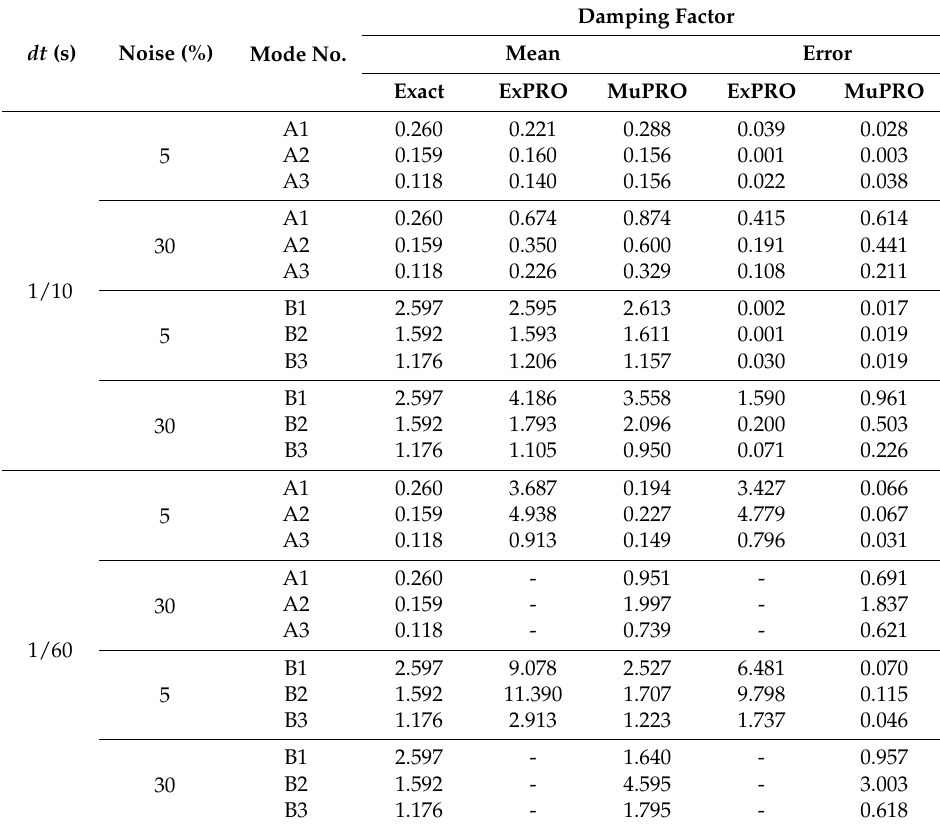
Table 3. Estimated damping factor and